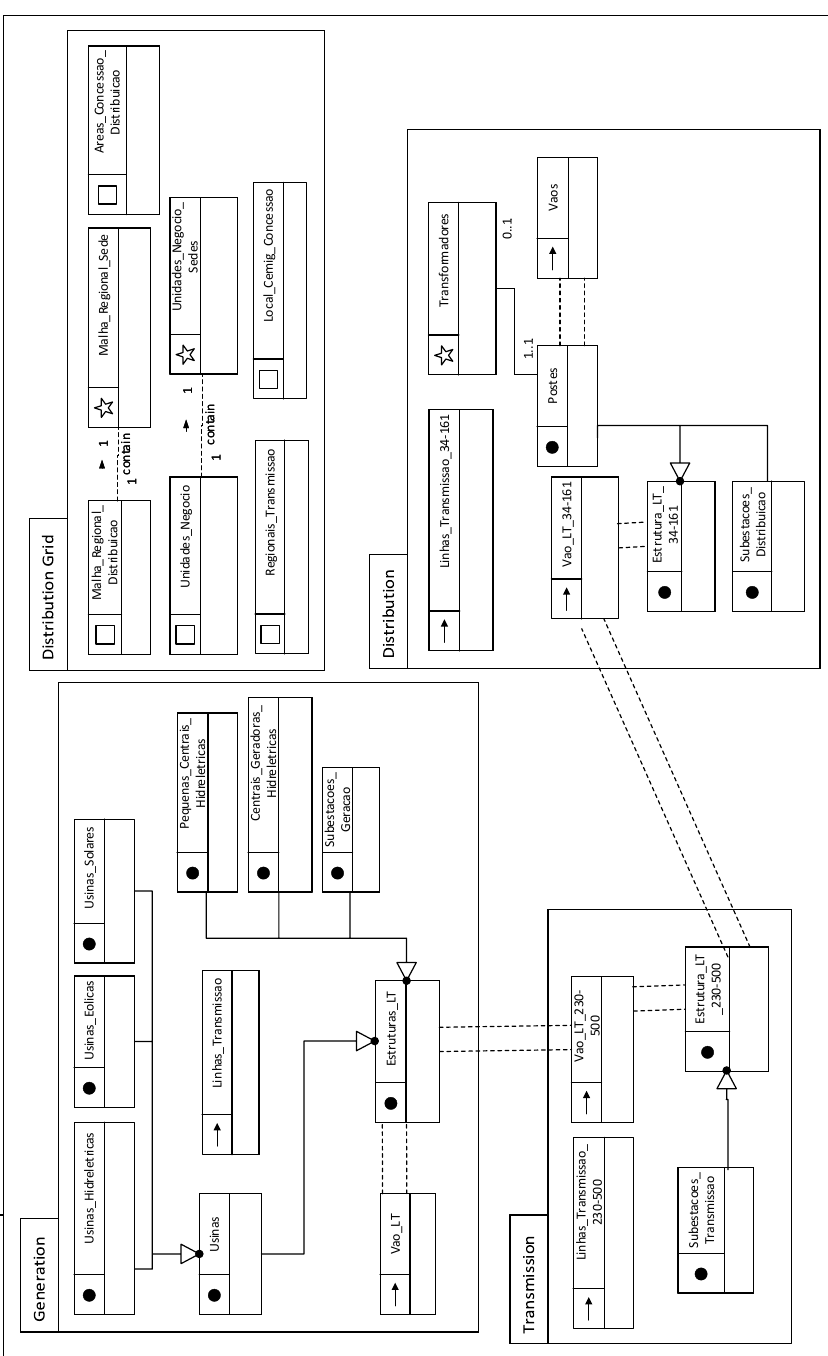
Figure 10. Classes related to the electric system and the distribution grid of the state of Minas Gerais from the conceptual model of SDI-Cemig’s